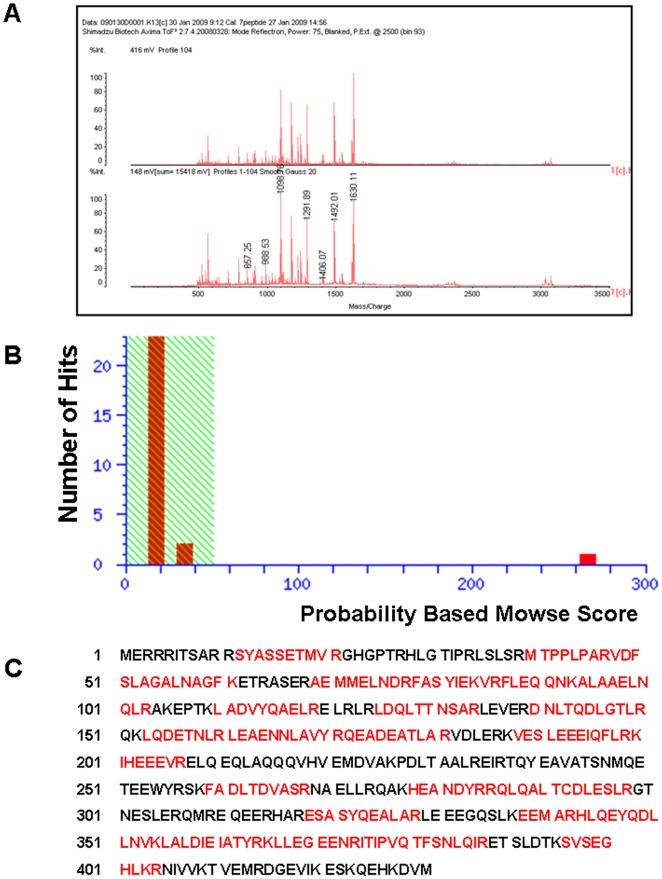
MALDI-TOF mass spectrum of the tryptic digest of spot 8.Spot 8 from Figure 7D was digested in gel with trypsin, and the resulting peptides were analyzed by MALDI-TOF MS as detailed in the experimental section. (A) Typical mass spectrum from a representative experiment. (B) Probability based Mowse Score. (C) Positions of matched peptides in the sequence of GFAP.